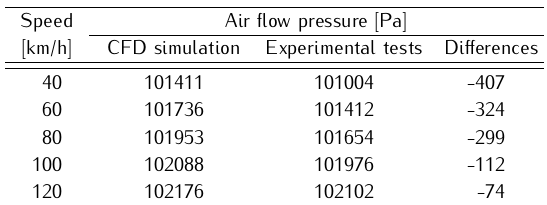
from vertical plane of the race-car axe of measure